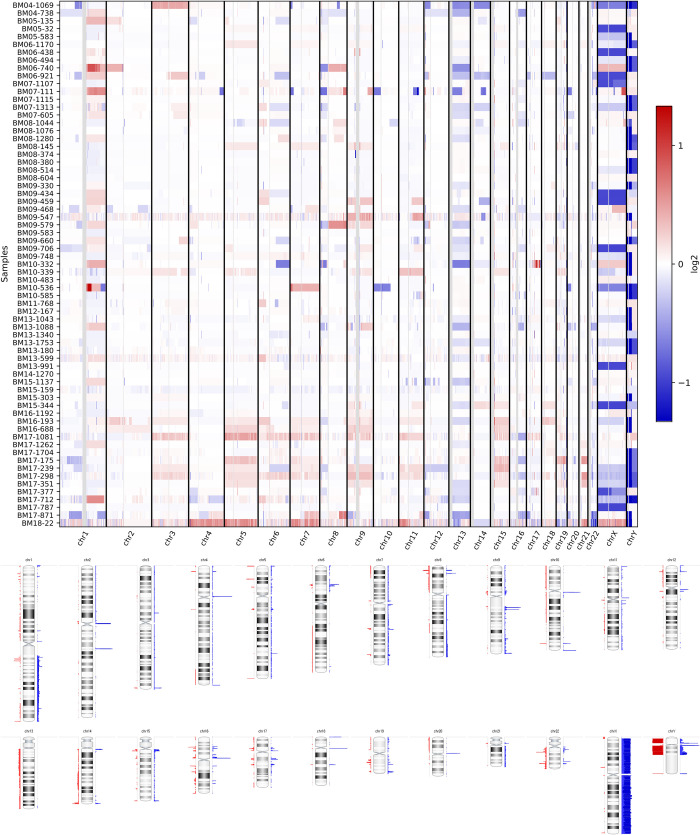
Summary plot of chromosomal gain and loss in 67 patients with newly diagnosed multiple myeloma determined using whole-exome sequencing and copy number analysis.(A) In the heatmap plot, each row represents one patient, while each column represents chromosomes 1–23, X, and Y in order. (B) Ideogram with regions of chromosomal gain and loss. Copy number gains and deletions are marked as blue and red bars to the right and left side of the ideogram, respectively.